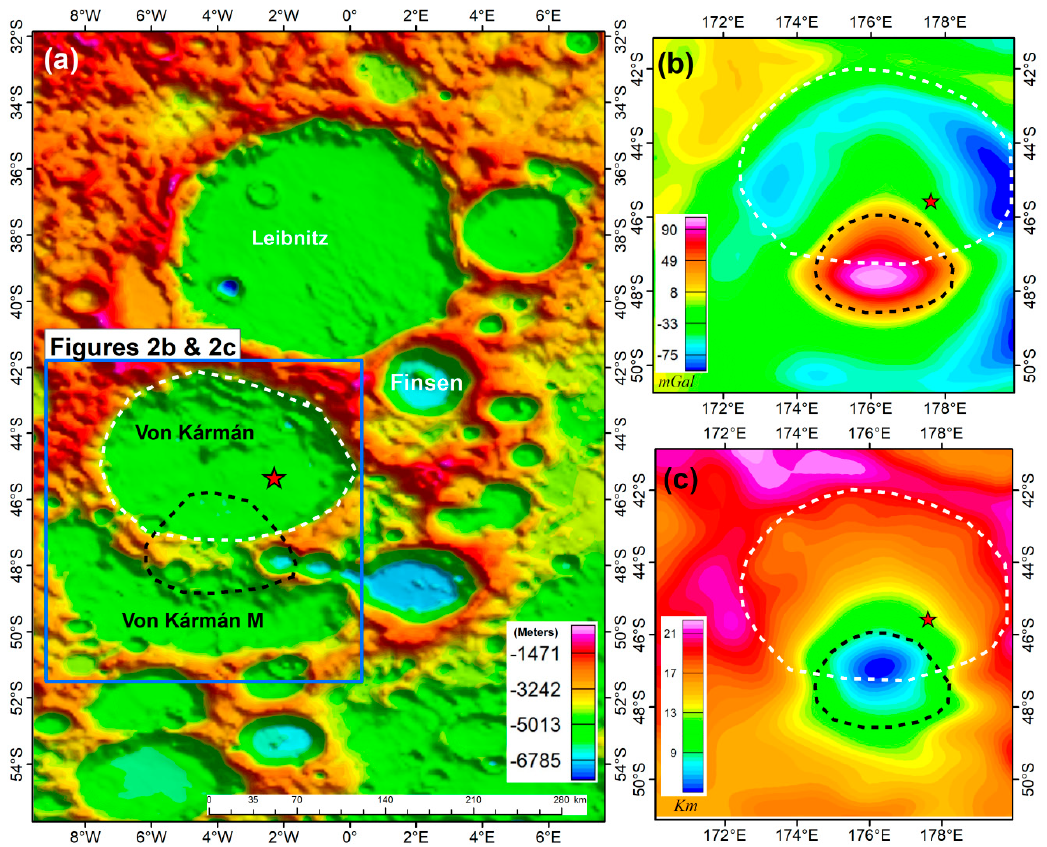
Figure 2. Study area. ( a ) Topographic map of the broader Von Kármán region and the surrounding craters, farside centred, after Barker et al. [8]. The Von Kármán Crater is enclosed by several other impact craters, namely, the Leibnitz crater in the north, the Finsen crater in the northeast and the Von Kármán M in the south. Also shown are the extent of our gravity inversion (Blue polygon), the boundary of the Von Kármán raised rim (White-dashed polygon) and the extent of high gravity region (Black-dashed polygon; Figure 2b). ( b ) Lunar Bouguer anomaly from the GRGM1200A gravity model available for the spherical harmonic degree and order 1200 [9], truncated between 6 − 450 degrees, nearside centred, after Goossens et al.[9] ; ( c ) The crustal thickness map of the Von Kármán Crater, nearside centred, after Wieczorek et al. [7]. The red pentagram shows the location of the Chang’E-4 landing site (177.59°E, 45.46°S; [11,12]).